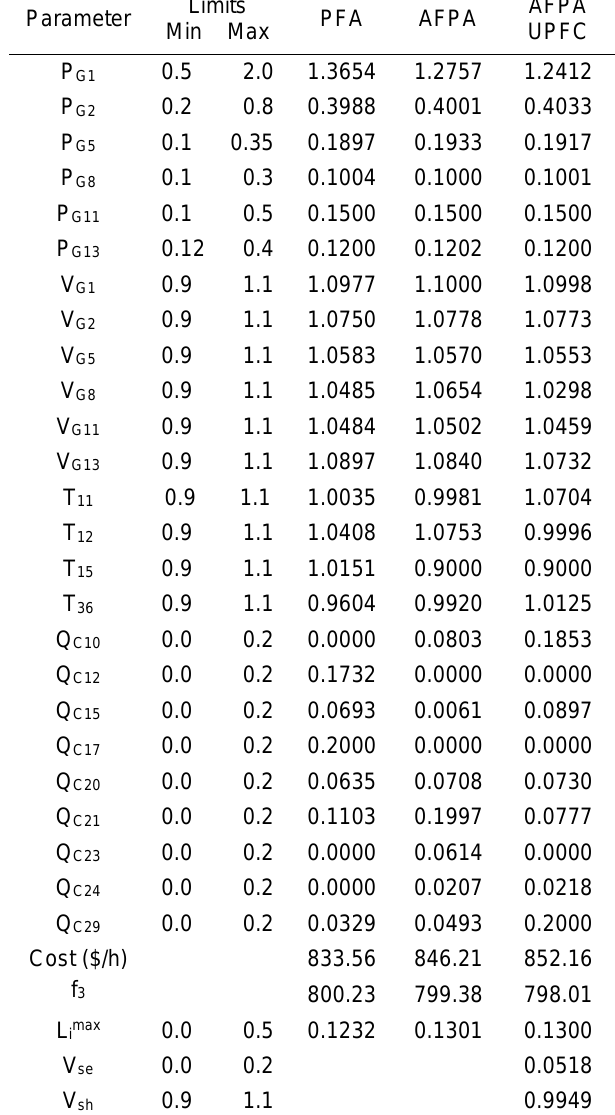
Table 6. OPF results for multi-objective function (f 3